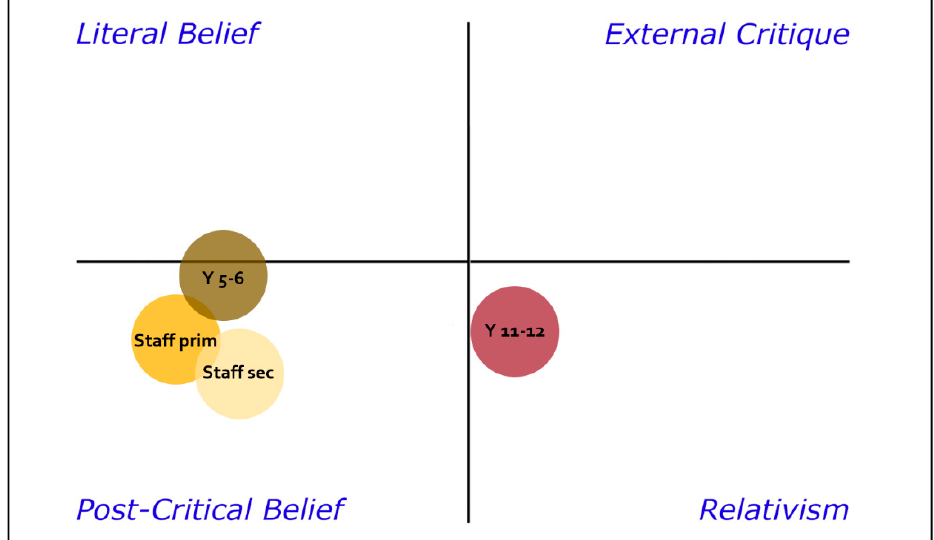
Figure 7. Position of students and staff in primary and secondary Catholic schools.